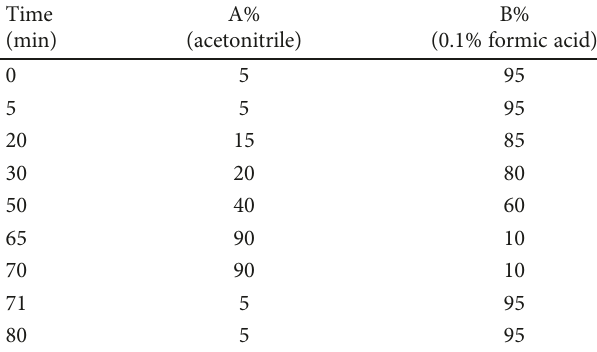
Table 1: Mobile phase program for HPLC